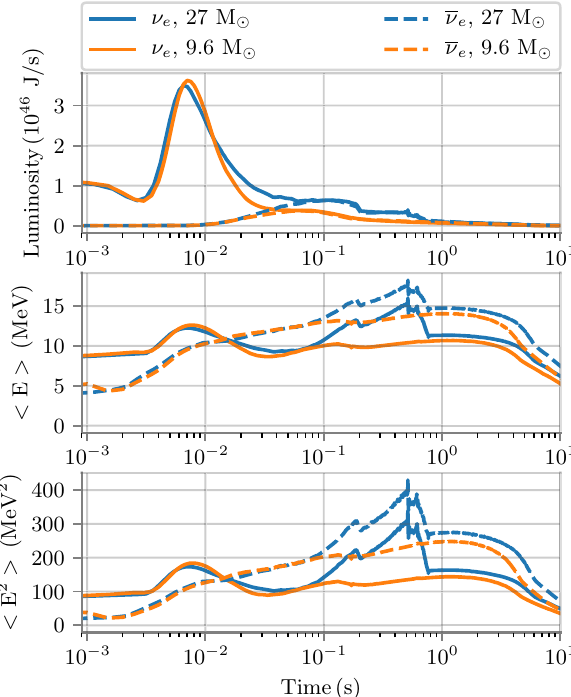
Fig. 2 Time dependence of the luminosity, the mean energy and the mean squared energy of neutrinos and antineutrinos for the CCSNe models used in this work. Data taken from [28]